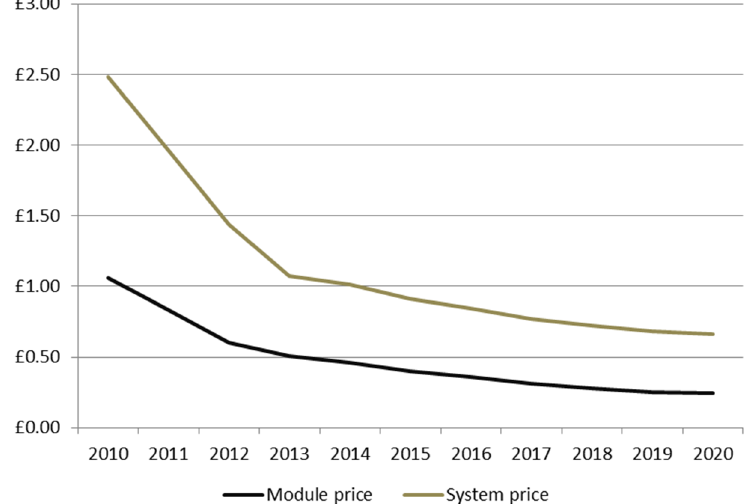
Figure 2. Full installed costs, UK ground-mounted systems, 2010–2020. Source: Our research, industry